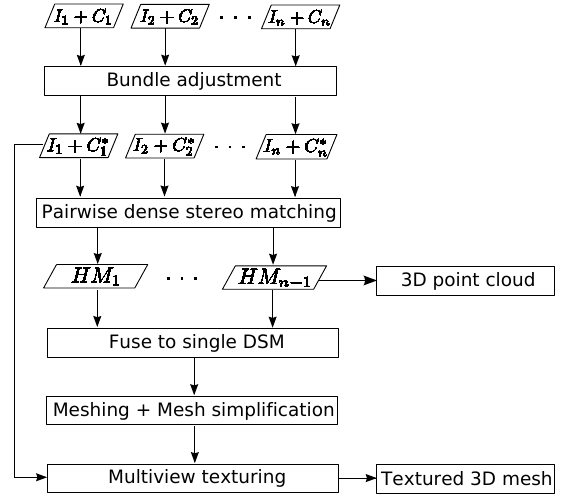
Figure 1: Workflow of the 3D reconstruction process with n input images I and camera poses C k n − 1 pairwise heightmaps HM